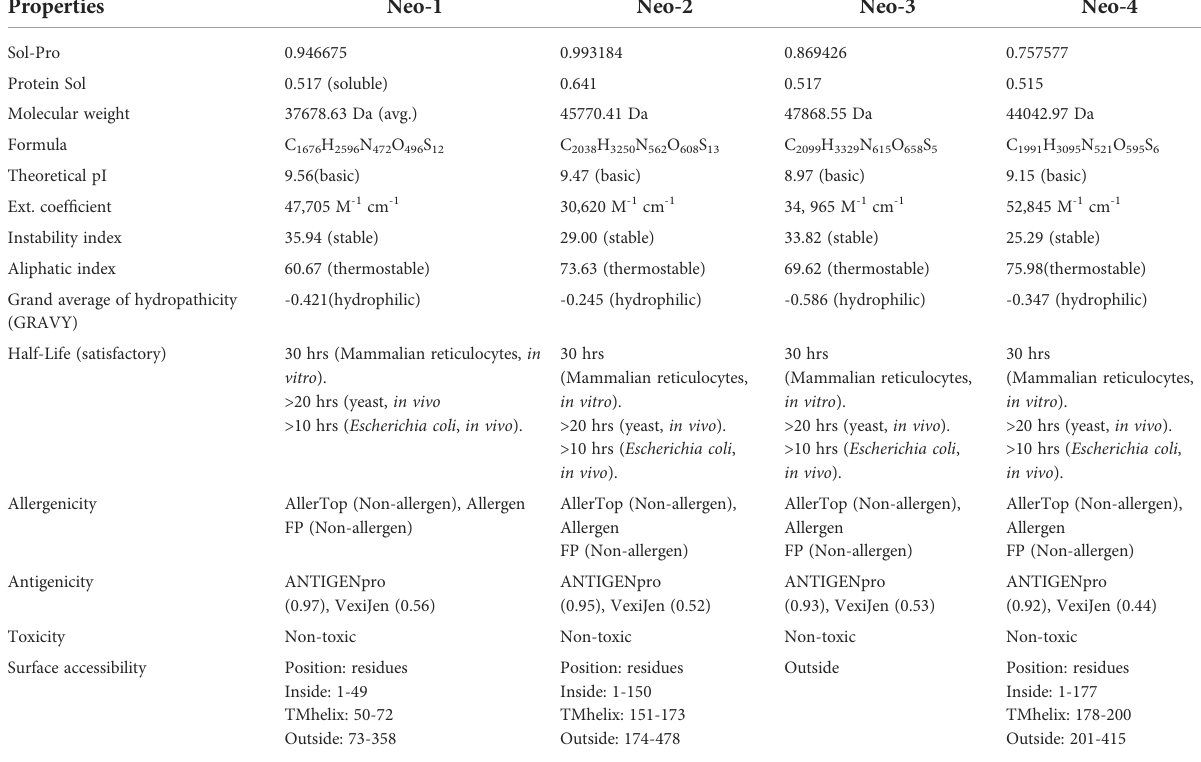
TABLE 6 Allergenicity, antigenicity, toxicity, surface accessibility, and physicochemical characteristics of proposed polypeptide-based vaccine constructs (Neo-1-4).